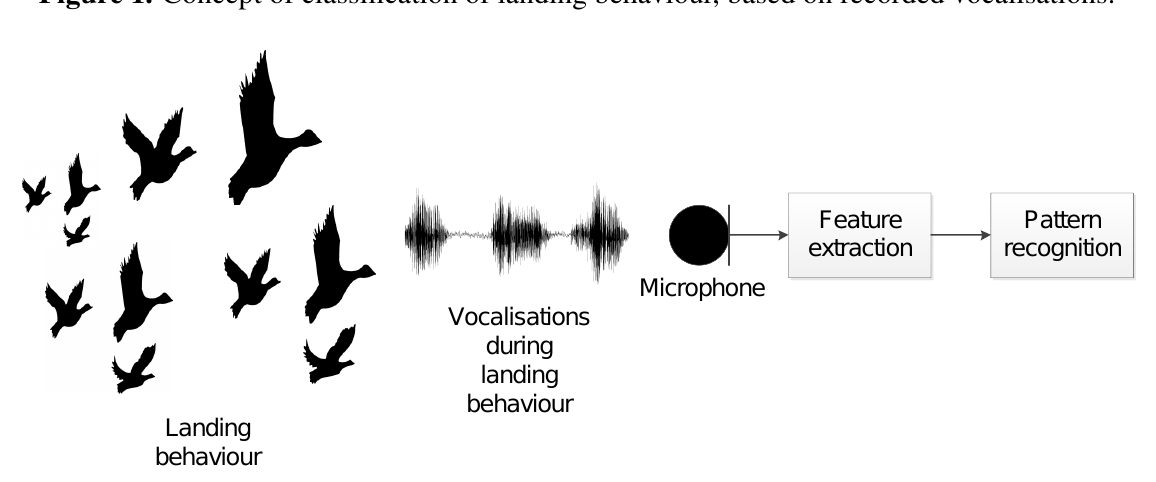
Figure 1. Concept of classification of landing behaviour, based on recorded